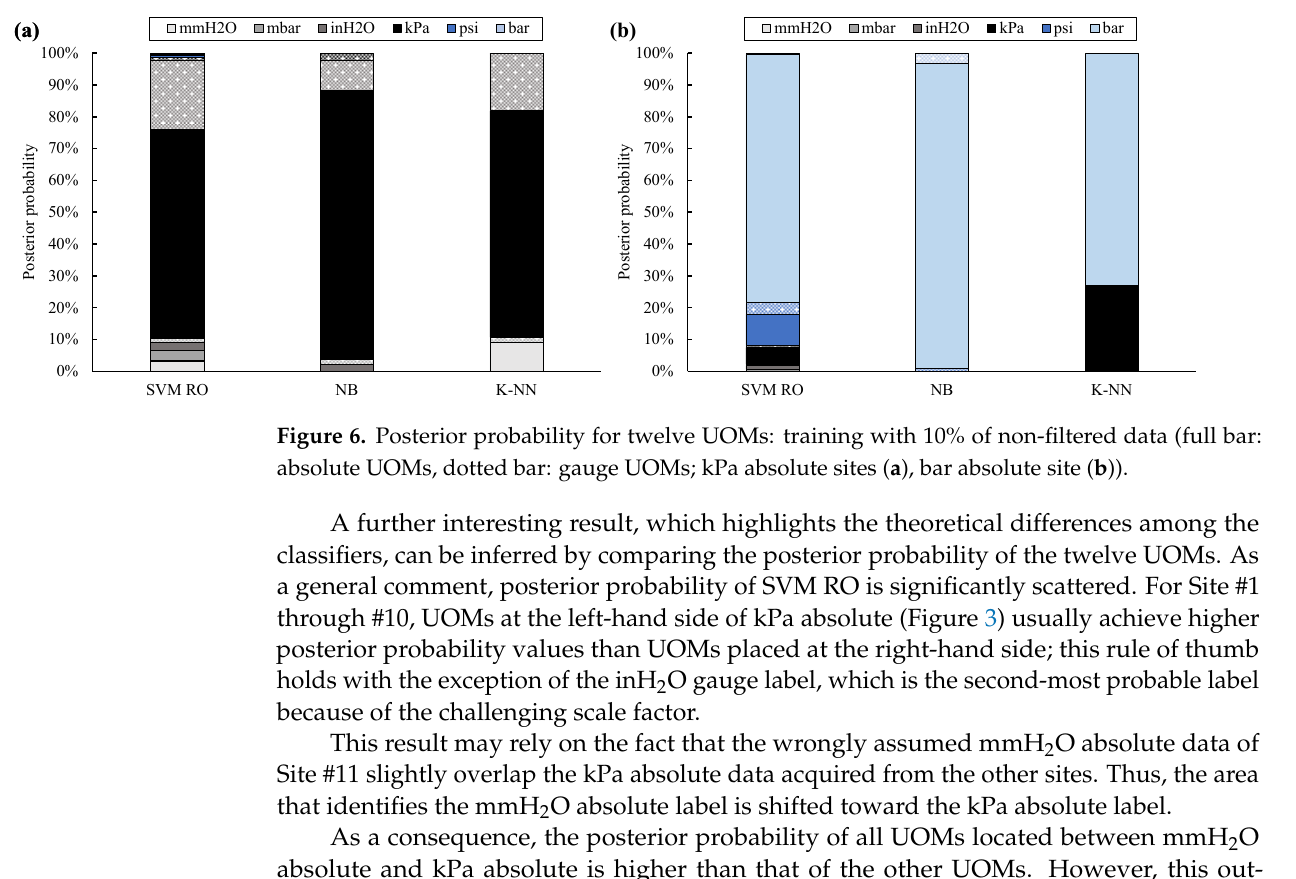
Figure 7. Posterior probability for twelve UOMs: site cross-validation by means of non-filtered data (full bar: absolute UOMs, dotted bar: gauge UOMs; kPa absolute sites ( a ), bar absolute site ( b )).